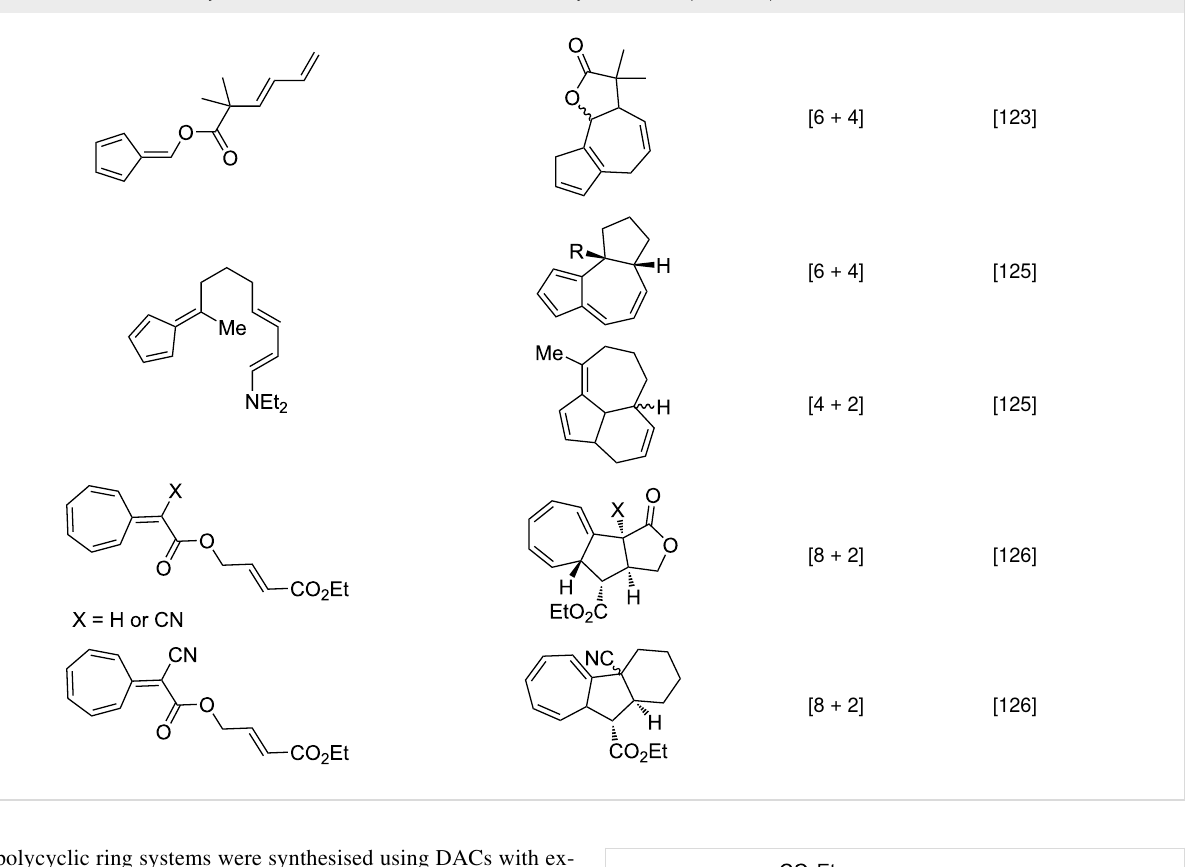
Table 1: Structures and cycloaddition notation of fulvene intramolecular cycloadditions.